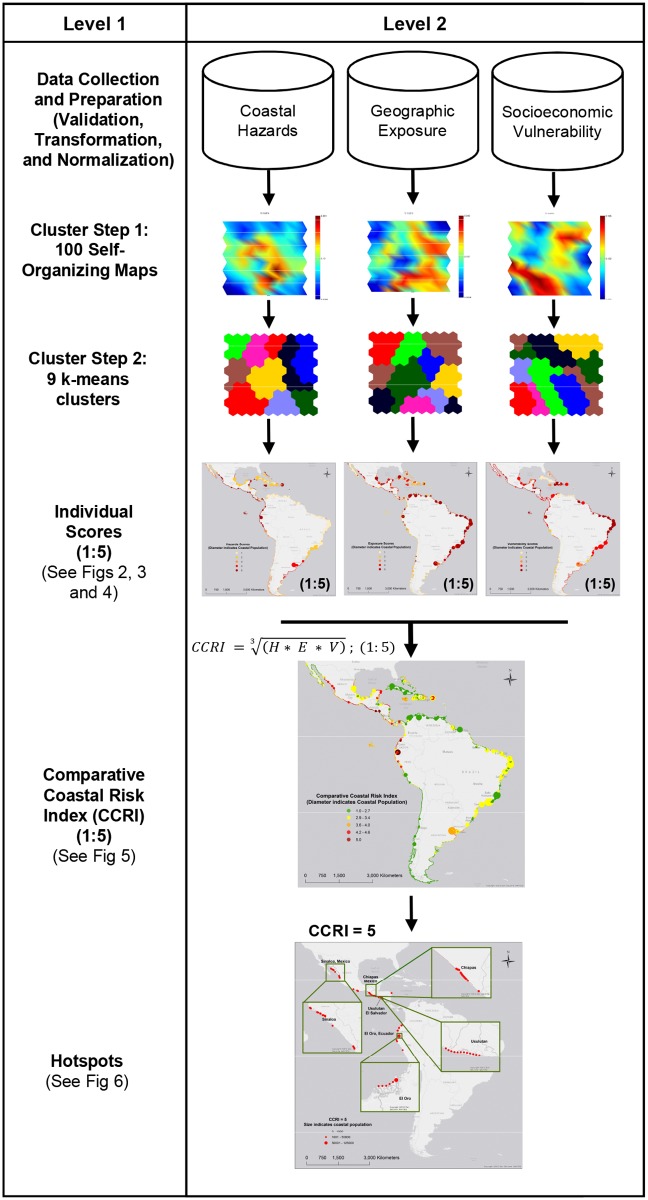
Methods flow chart.